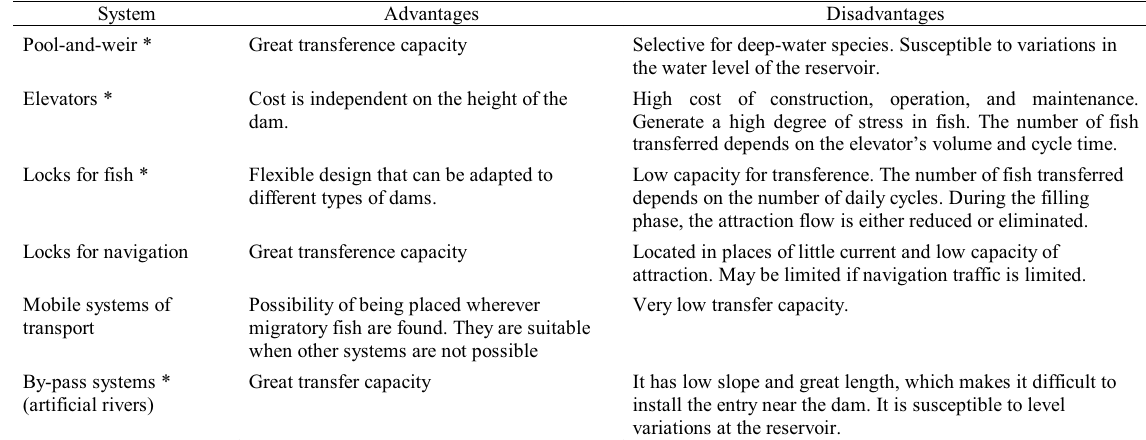
Table 3. Comparison among different fish passage systems installed (*) or adaptable to large South America rivers.